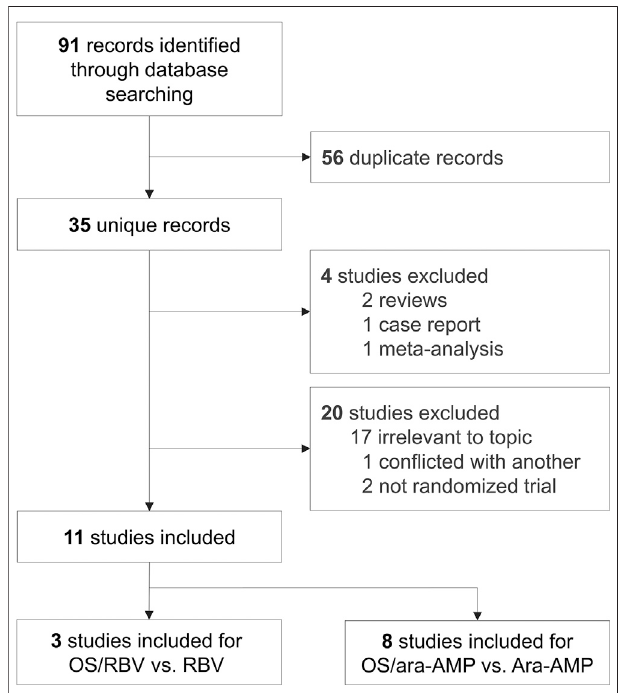
FIGURE 1 | Flow chart of study